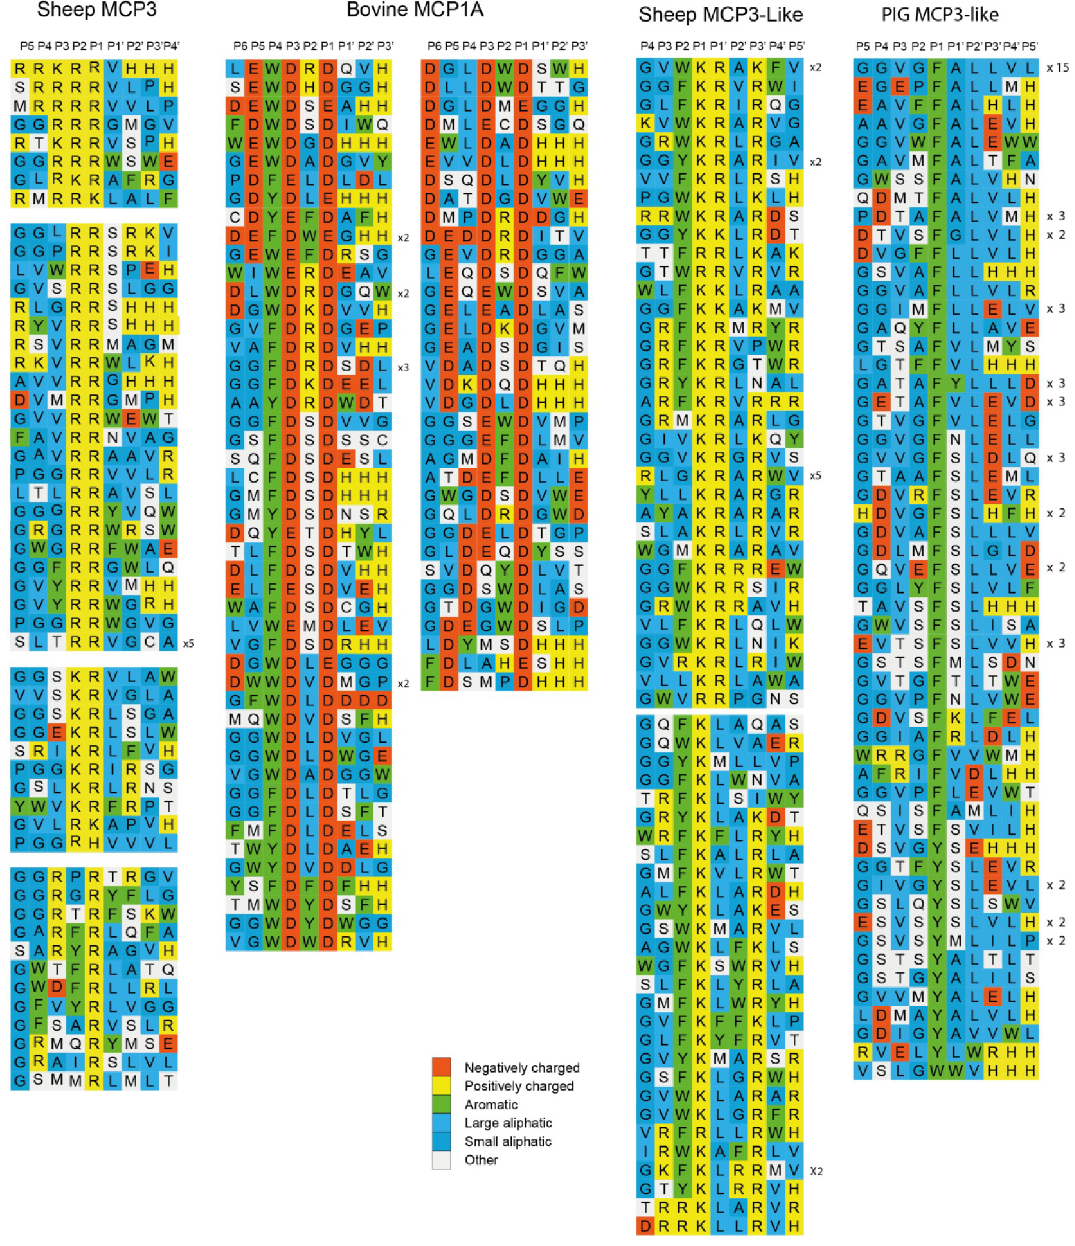
Fig 6. Phage display analysis of sheep MCP3, cow MCP1A, sheep MCP3-like and pig MCP3-like. After the last selection step of the phage display analysis, phages released by proteolytic cleavage of the three proteases were isolated and the sequences encoding the nonamers were determined. The general sequence of the T7 phage capsid proteins are PGG(X) 9 HHHHHH, where (X) 9 indicates the randomized nonamers. The protein sequences were aligned into a P4-P3´ consensus, where cleavage occurs between positions P1 and P1´. If the sequence as found more than once this is indicated by the corresponding number to the left of the sequence. The amino acids are colour coded according to the side chain properties as indicated in the legend.